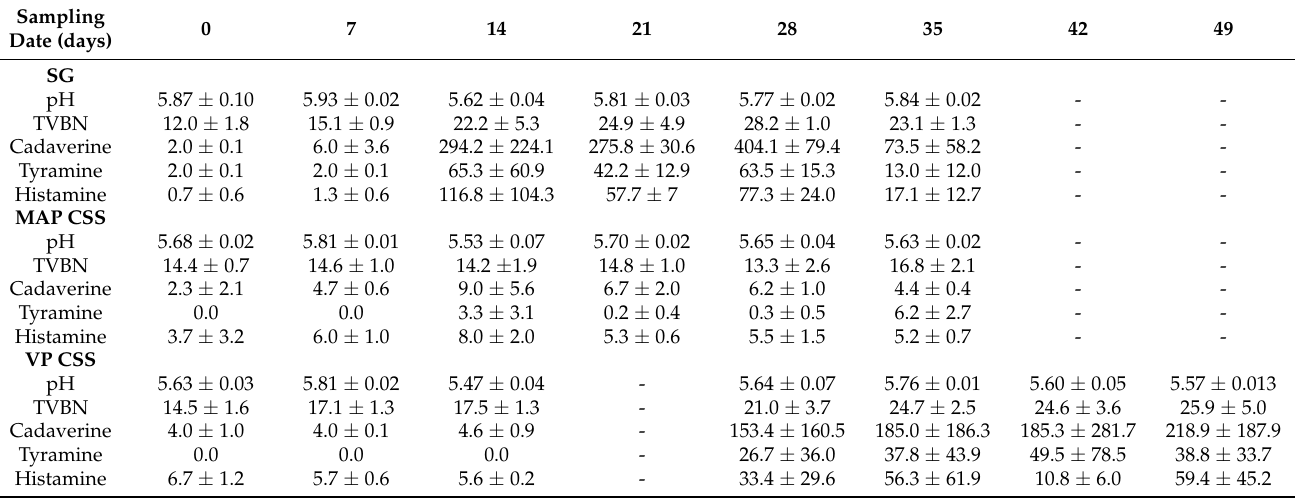
Table 1. pH evolution, TVBN (mg-N/100g) and biogenic amines (mg/kg) contents in the salmon gravlax (SG), vacuum- packed (VP) and modified atmosphere packed (MAP) CSS during storage at 4 ◦ C for 1 week and then at 8 ◦ C. Sampling Date